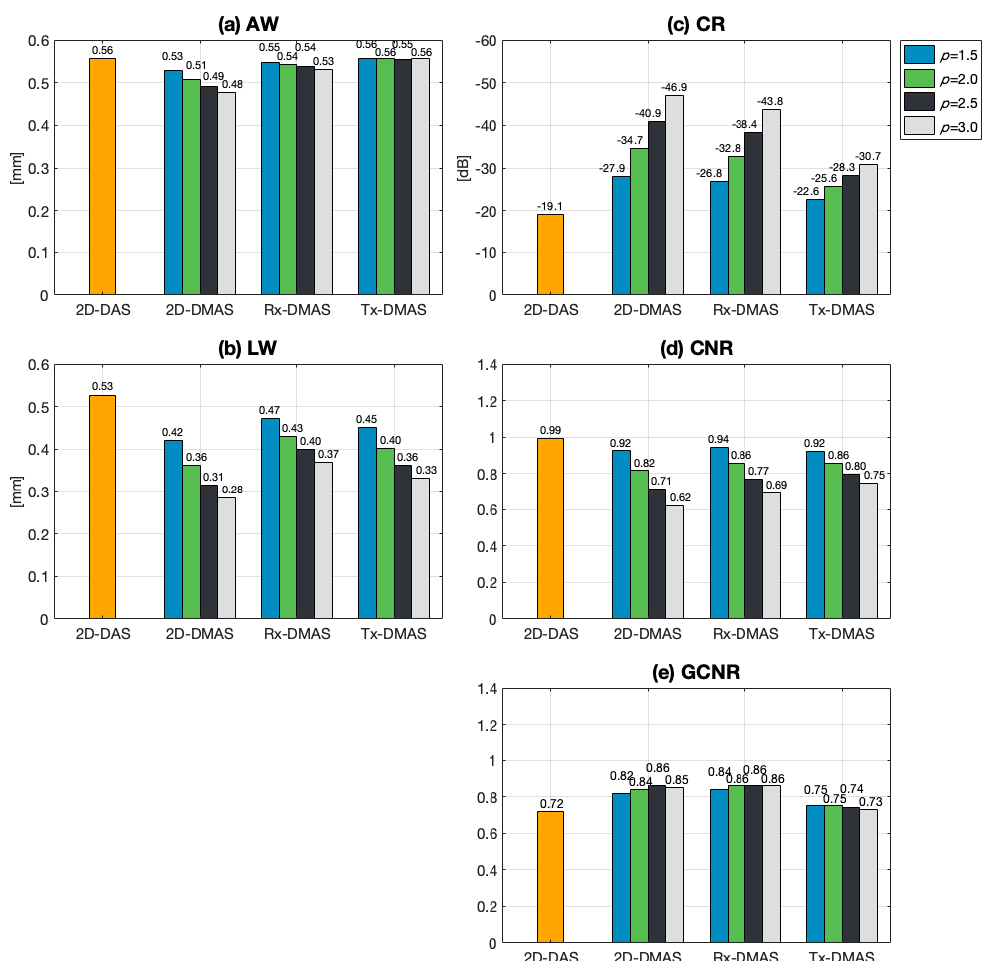
Figure 4. Quantitative analyses of image resolution and image contrast for the experimental B-mode images in Figure 3.